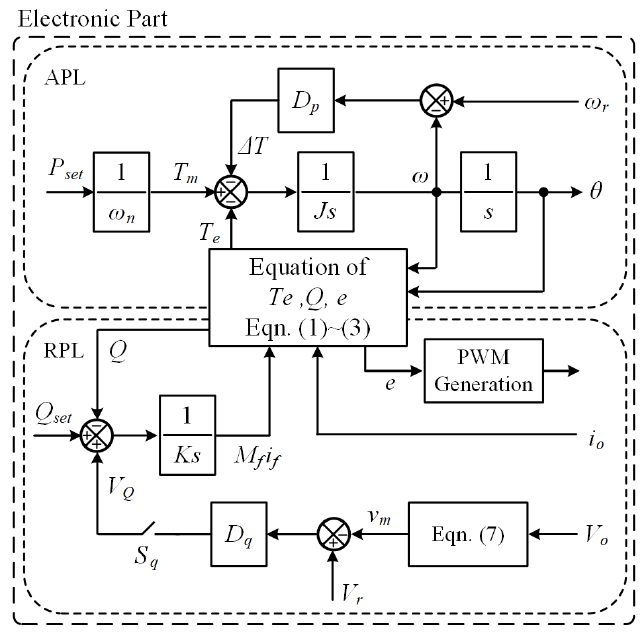
Figure 2. Conventional synchronverter control